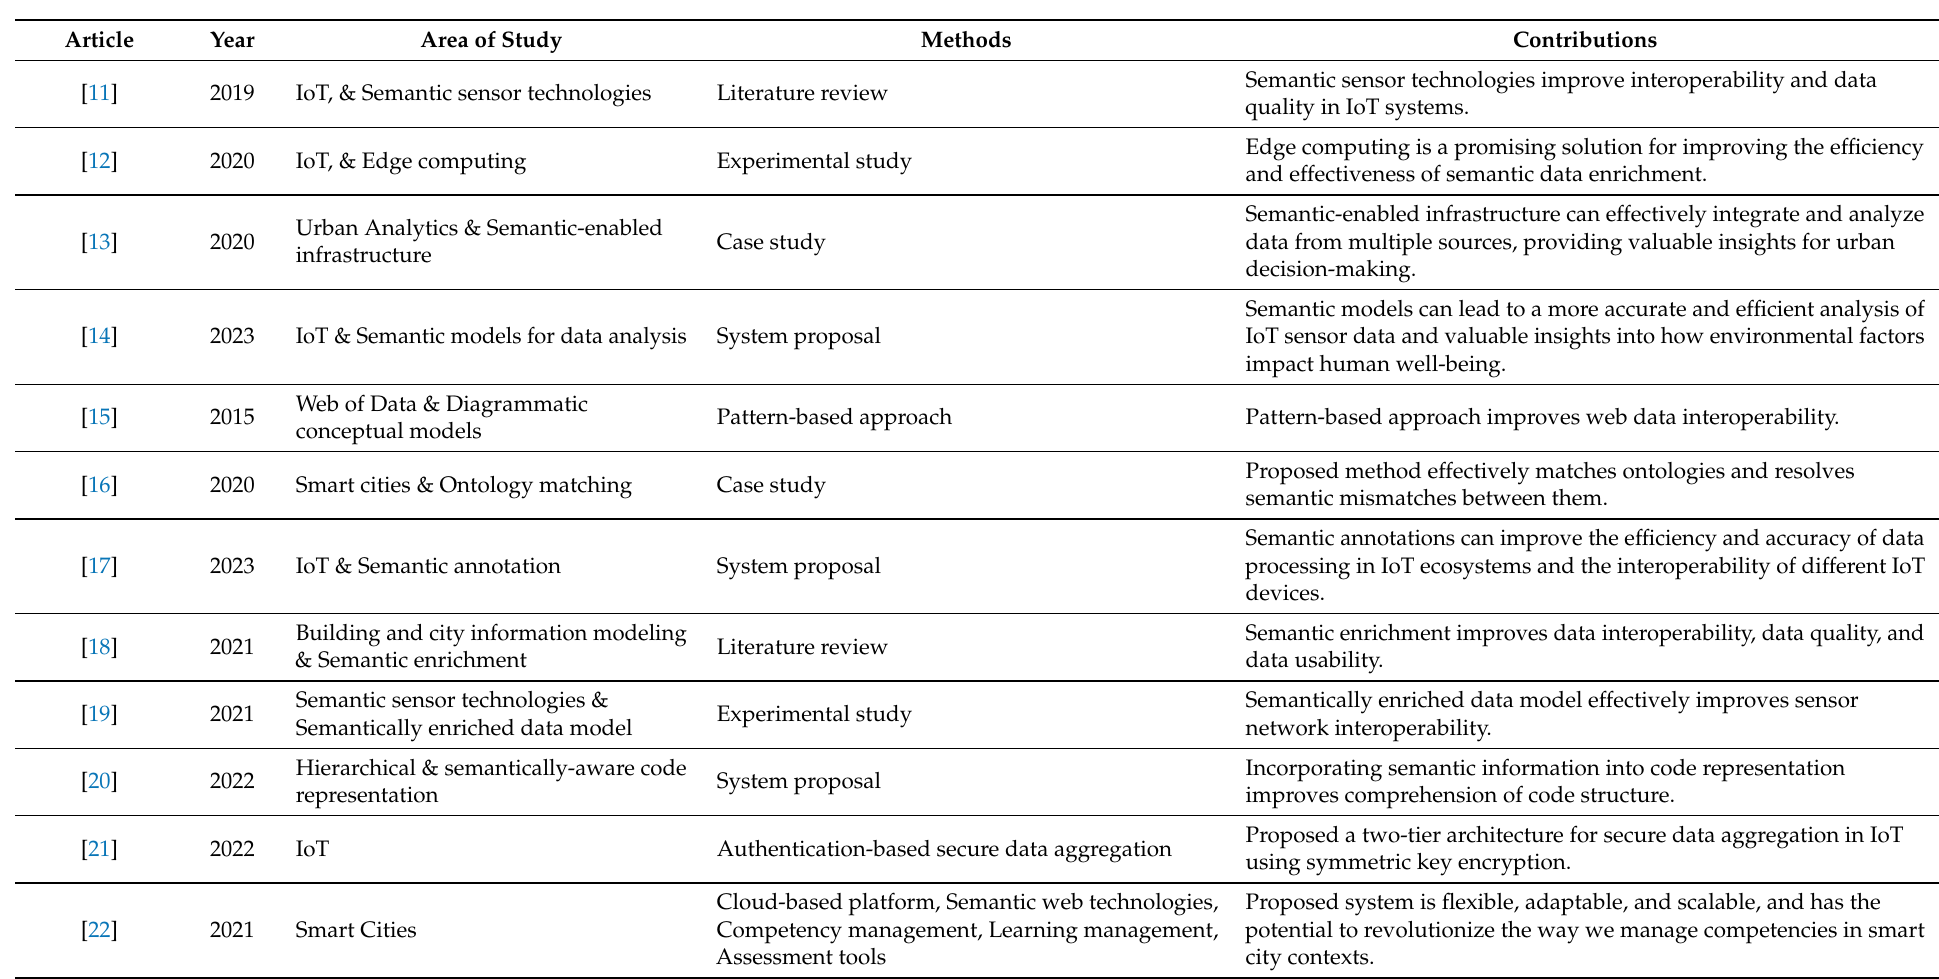
Table 1. Summarized reviewed